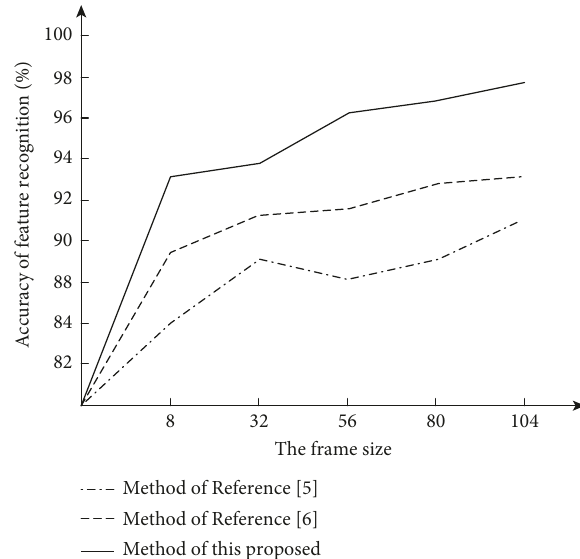
Figure 3: Comparison of feature recognition accuracy of different algorithms.